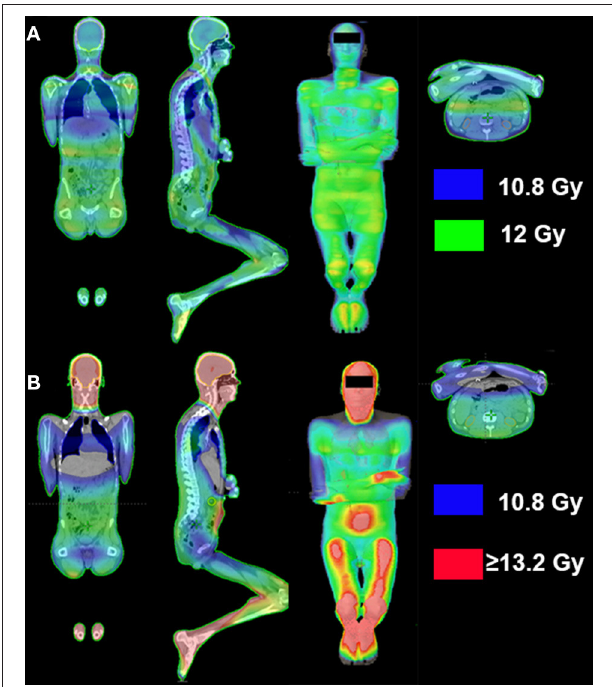
FIGURE 2 | Conventional vs. SSD IMRT-planned total body irradiation dose distribution. (A) Computed tomography (CT)-planned, image-guided intensity-modulated radiotherapy (IMRT) dose distribution with lateral-beam setup at source-surface distance (SSD) ( 123); dose reductions were planned over lungs, and kidneys. (B) CT-planned two-dimensional conventional total body irradiation dose distribution with a lateral-beam setup, with lung dose reduction using lung blocks; the isowash-depicted dose range in the images represents 90% (10.8Gy; blue) to ≥ 110% ( ≥ 13.2Gy; red) of the prescribed dose.